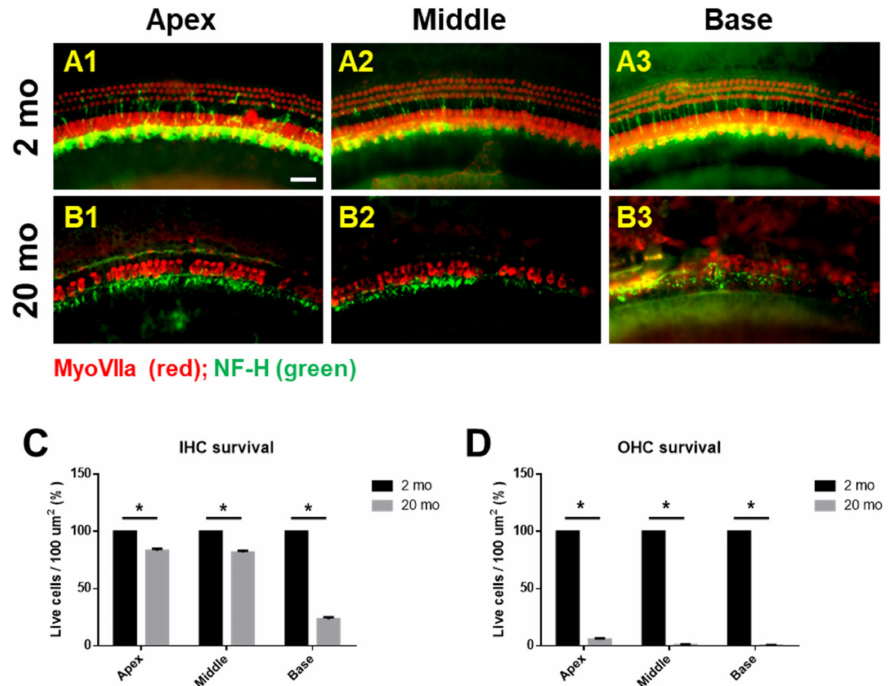
Figure 2. Cochlear hair cells are significantly lost in aged mice. Whole-mount preparations of the auditory epithelium in the 2 month-( A1 – A3 ) and 20 month-old ( B1 – B3 ) mice. Tissues were stained for myosin VIIa (red) to visualize the hair cells and then photographed using epifluorescence. ( A , B ) OHCs were more noticeably destroyed on the middle and basal turns of the cochlea in the aged mice (B1–B3) compared to the young mice ( A1 – A3 ). ( C , D ) Quantitative analysis of hair cell survival on IHCs ( C ) and OHCs ( D ): apex, middle, and basal turns. A1 and B1, apical turn; A2 and B2, middle turn; A3 and B3, basal turn; OHC, outer hair cell; IHC, inner hair cell. Scale bar = 30 µ m. All graphs represent mean ±